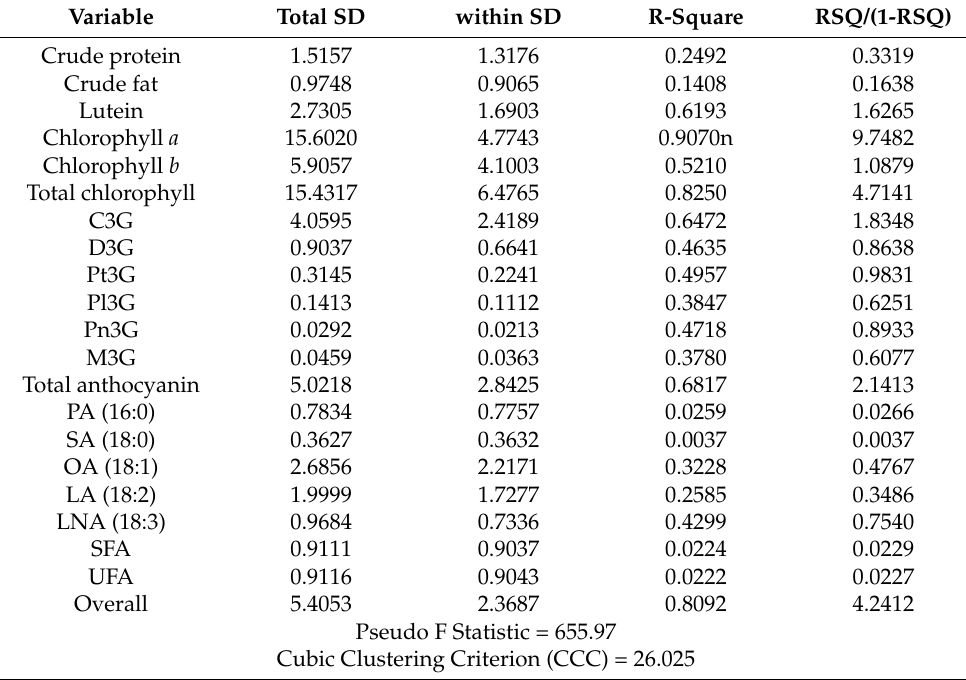
Table 5. Statistical variables for clusters of 20 seed composition traits of 468 black soybean germplasms with green cotyledons, including check cultivars ‘Cheongja 3’ and ‘Cheongja’.